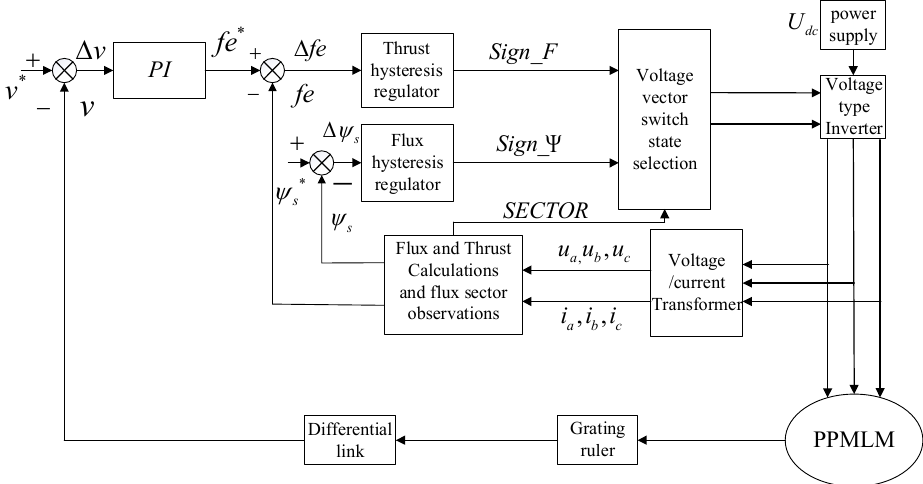
Figure 1. Block diagram of the direct thrust force control system for PPMLM. In Figure 1, * v is reference speed; v is speed error; * fe is control input; fe is the calculated motor thrust; fe is the thrust error; * is the given primary flux linkage; s is the calculated primary flux linkage; is the primary flux linkage error; s s _ Sign F is the thrust change signal; _ Sign is the magnetic link amplitude change u , u , u is the primary three-phase signal; Sector is the magnetic link position signal; a b c i , i , i is the primary three-phase winding current; and U terminal voltage; a b c dc